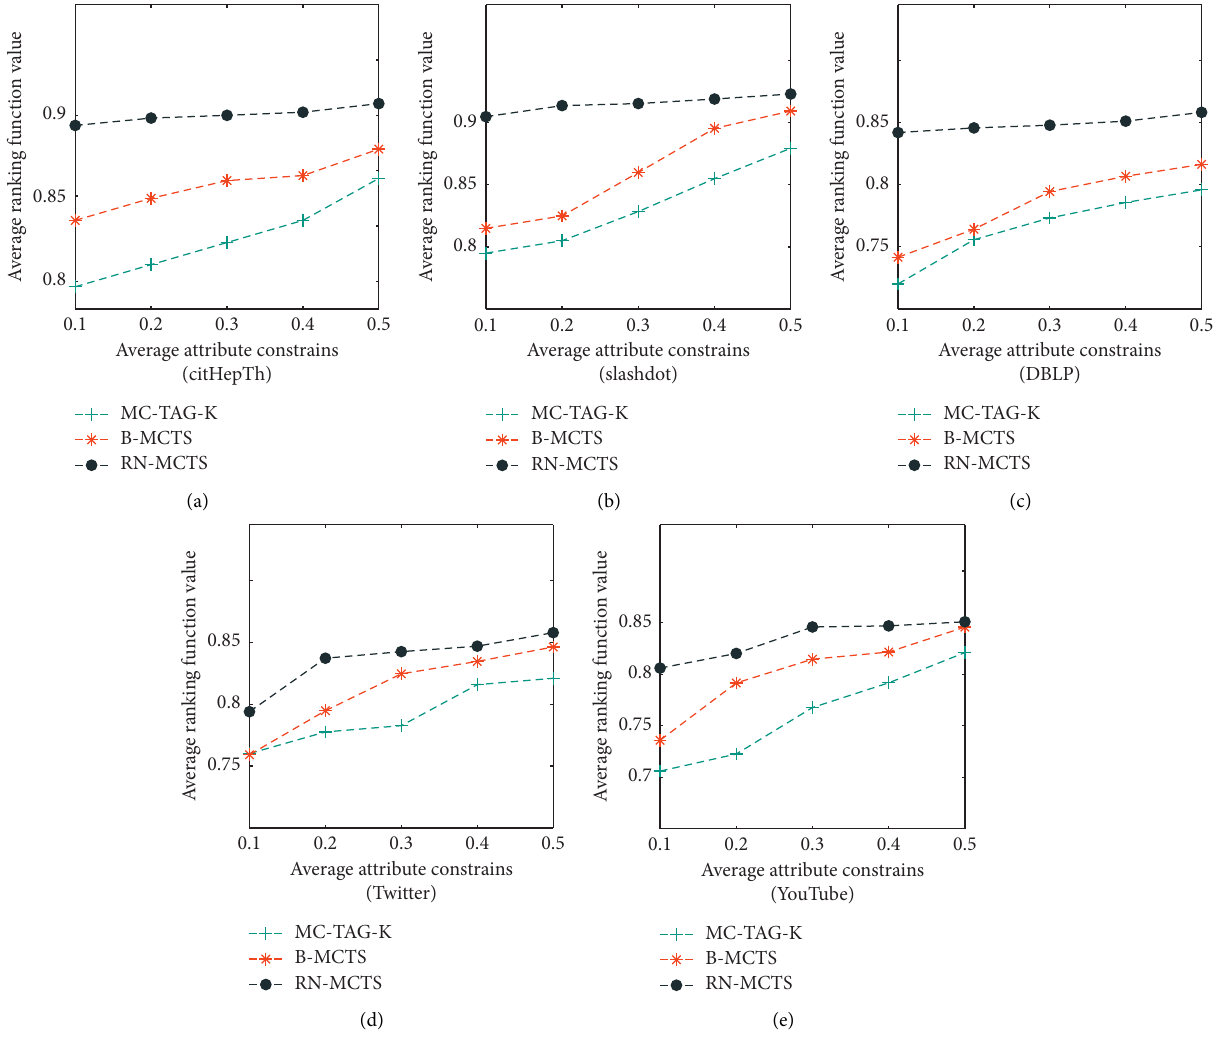
Figure 2: The average ranking function value based on different